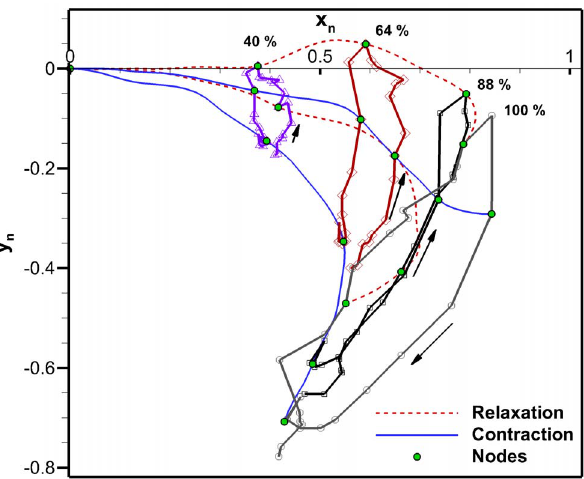
Fig. 11. Four-segment anatomical model bell trajectory. Bell trajectory at node locations of the four- segment anatomical model during the second swimming cycle.